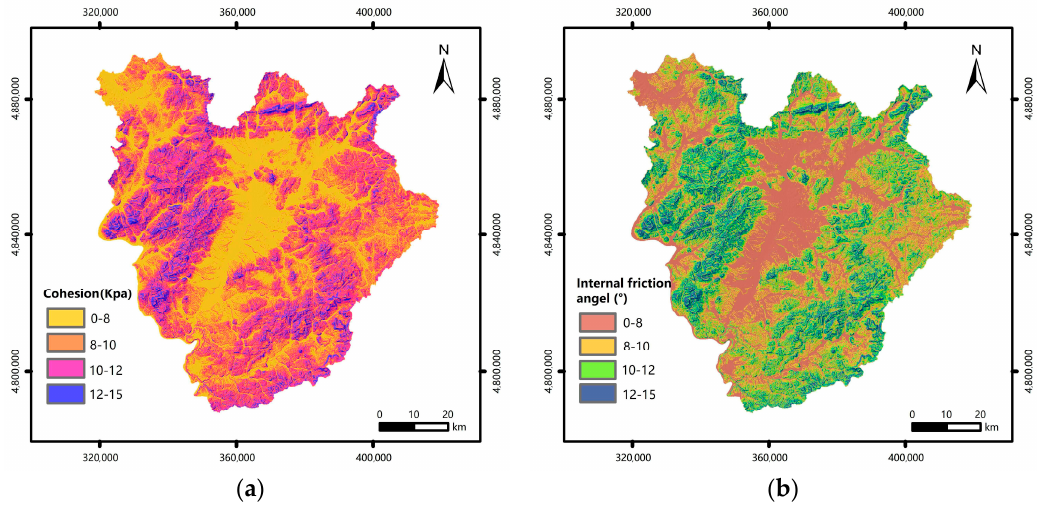
Figure 6. Distribution of mechanical parameters of soil in Jiaohe County. ( a ) Distribution of cohesion (kPa); ( b ) Distribution of internal friction angle (°).